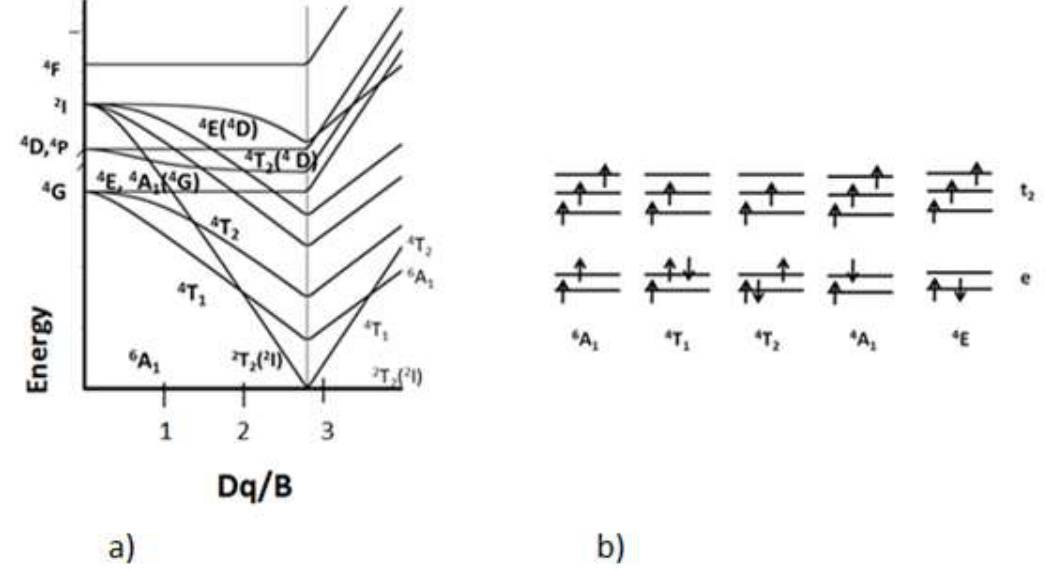
Figure 1. The energy levels of d 5 ion: ( a ) simplified Tanabe–Sugano diagram (sketched after [7]); ( b ) electronic configuration of d 5 ion, high spin (HS) and tetrahedral coordination.